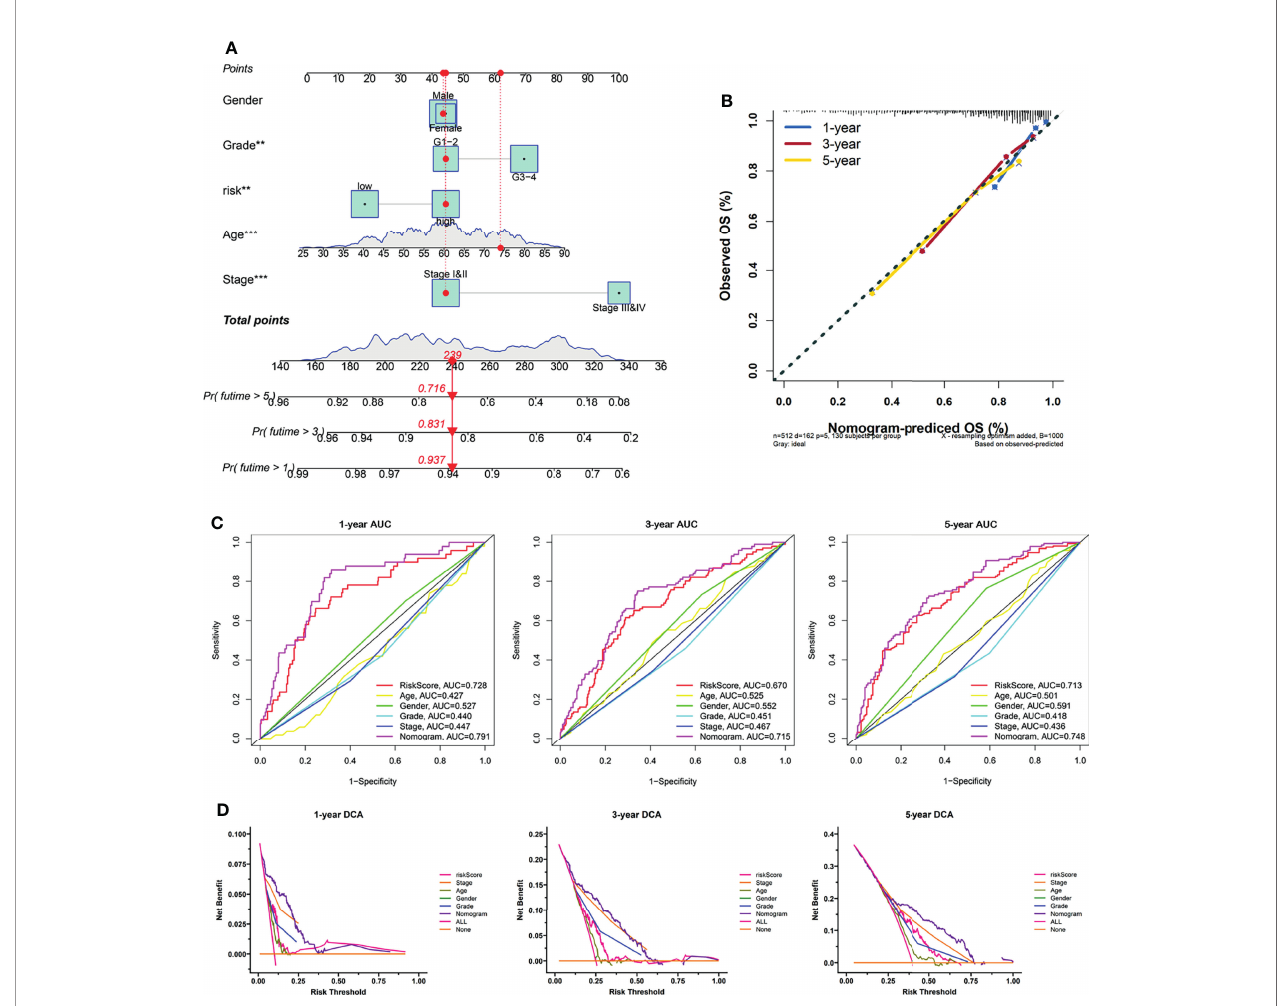
FIGURE 6 | Construction of a nomogram predicting the overall survival (OS) of patients with kidney renal clear cell carcinoma (KIRC) in The Cancer Genome Atlas (TCGA) cohort. (A) Nomogram based on the lactate-related prognostic signature (LRPS), age, gender, tumor grade, and stage. (B) Calibration curves for internal validation of the nomogram. (C) Time-dependent receiver operating characteristic (ROC) curves of the nomogram in predicting the 1-, 3-, and 5-year OS. (D) Decision curve analysis (DCA) of the nomogram. ** p < 0.01, *** p <